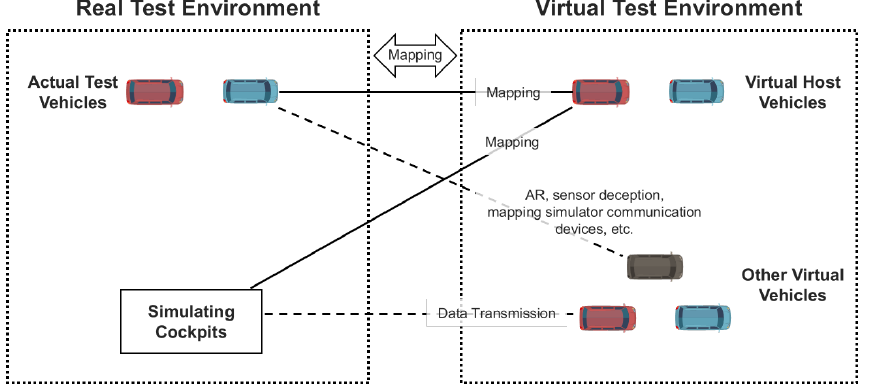
Figure 6. Environment configuration for parallel testing proposed by J. Wang et al. Application level security evaluation should be performed in an environment where a real device is mapped to a virtual test environment, as shown the actual test vehicle in this